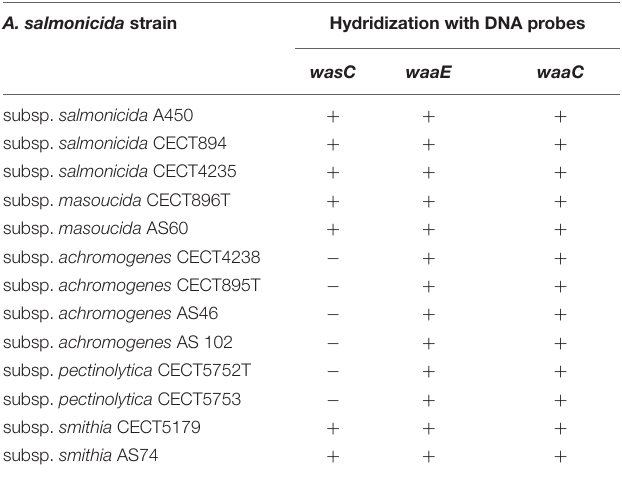
TABLE 3 | Hybridization studies with several DNA probes of A. salmonicida strains from different subspecies.